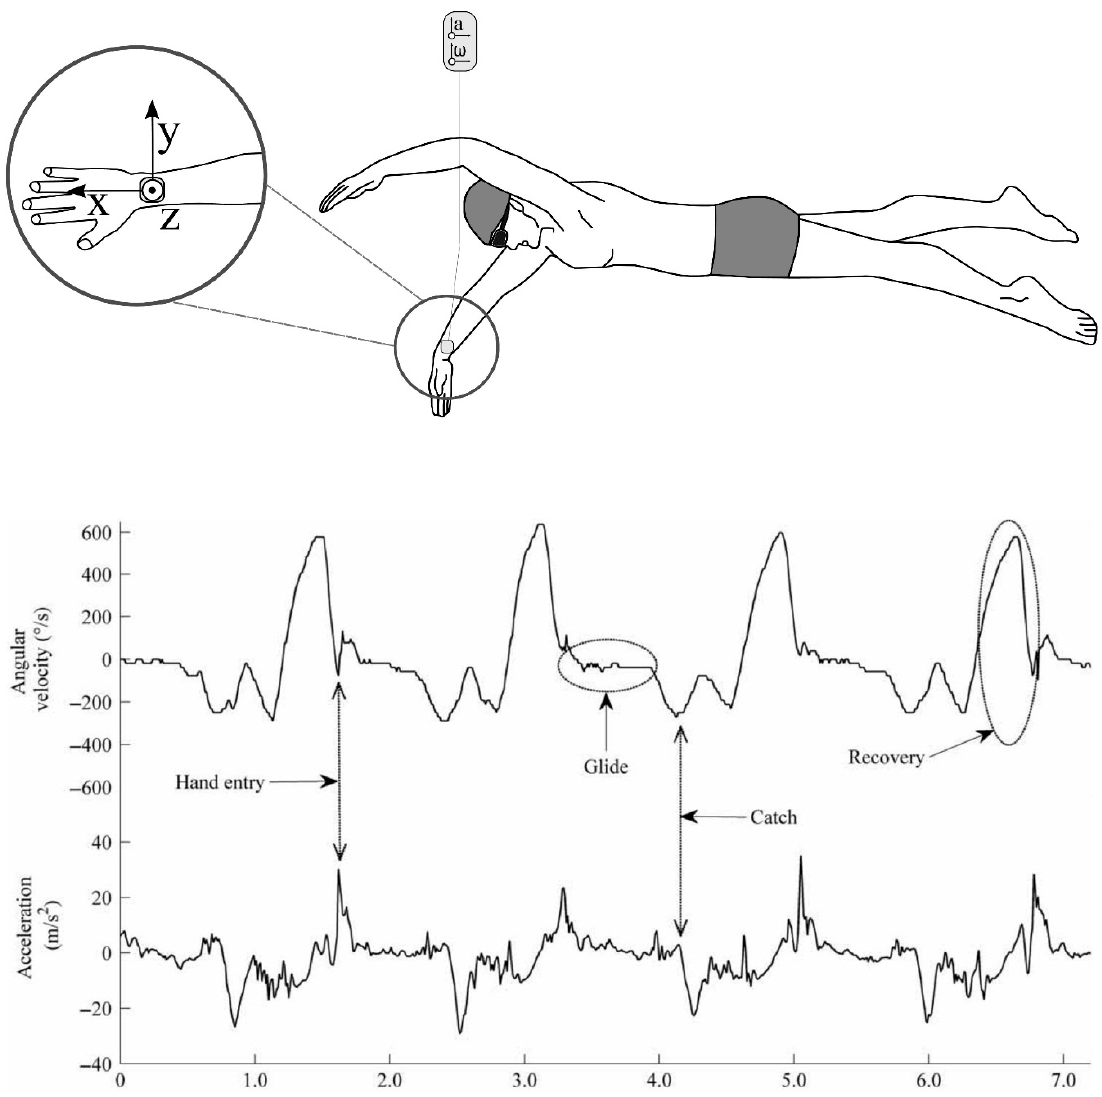
Figure 7. Comparison of signal output from both gyroscope and accelerometer sensors for four arm strokes. The signal displayed is from the Y-axis (ulnar-radial direction). It can be seen that the angular velocity pattern that is obtained is smoother and may facilitate easier feature detection of key events such as hand entry; glide; catch; and recovery. Reproduced with permissions from James, Leadbetter, Neeli, Burkett, Thiel and Lee [53].